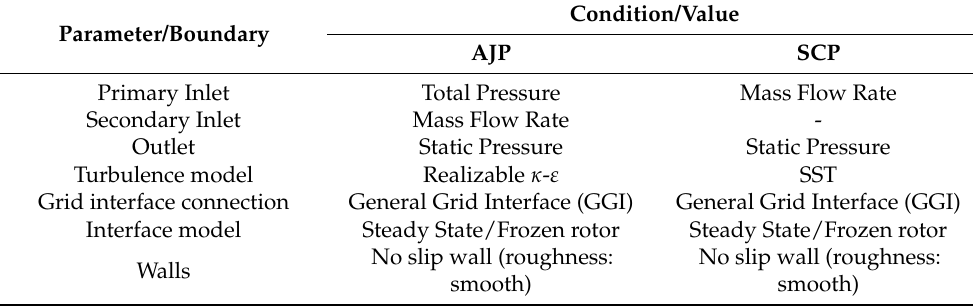
Table 6. Information of boundary conditions for CFD analysis of AJP and SCP models.